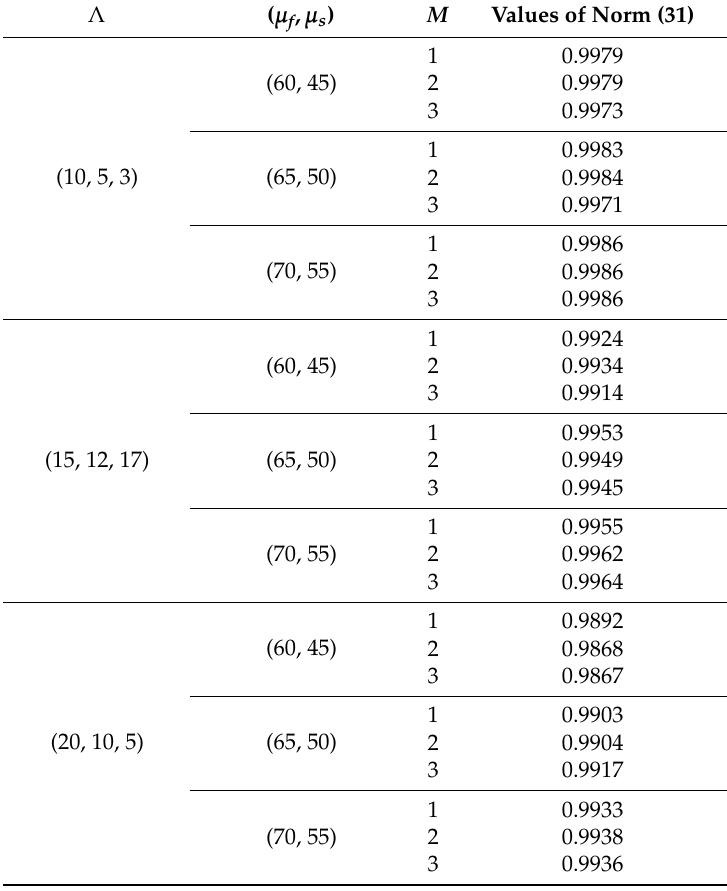
Table 2. Accuracy of the developed algorithm for calculation of steady-state probabilities. Case of varied values of intensities of MMPP